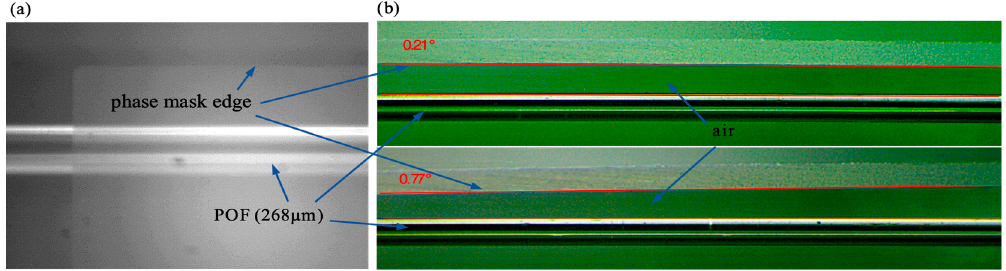
Figure 5. Images of the POF and the phase mask used for evaluation of the angle θ ( a ) and tilt angle ϕ ( b ).